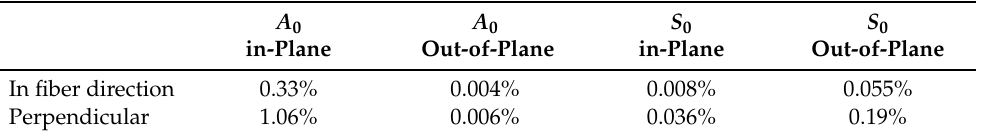
Table A2. Calculated mean error for 3D model at